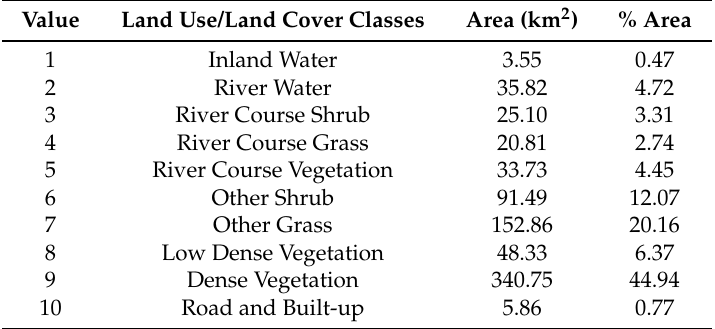
Table 2. Land use/land cover characteristics generated from satellite image using supervised